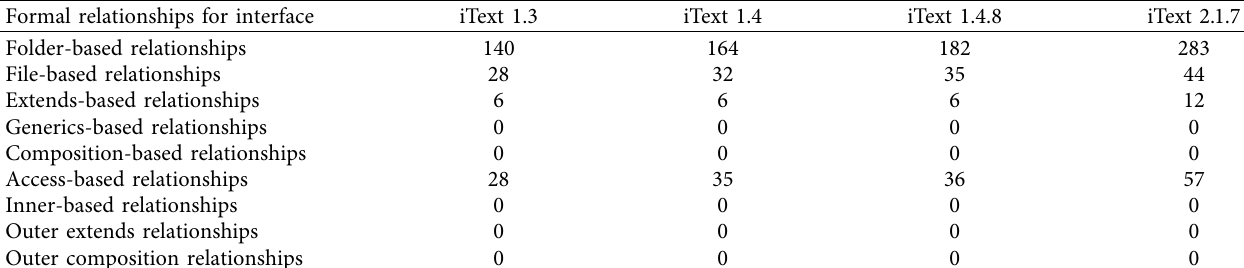
Table 9: Formal relationships for interface in iText.